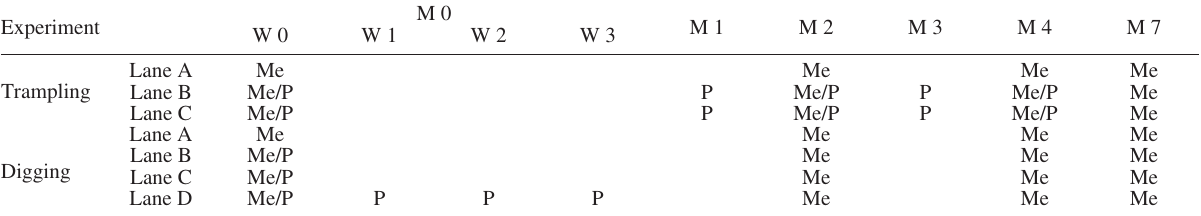
Table 1. – Chronogram of the experiments. Measurements (Me), pressure (P) and both (Me/P). W, week; M, month. The same experimental design was replicated in plot 1 and in plot 2. Experiment